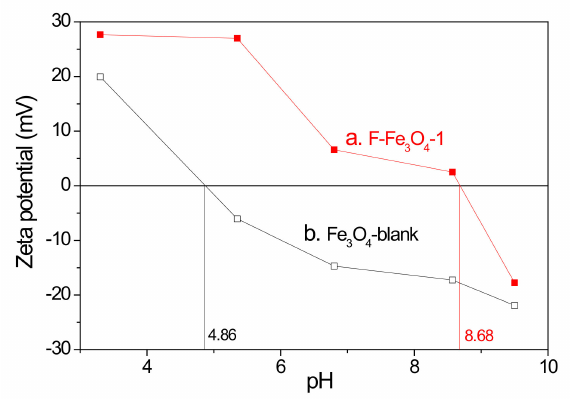
Figure 8. Zeta potentials at different pH